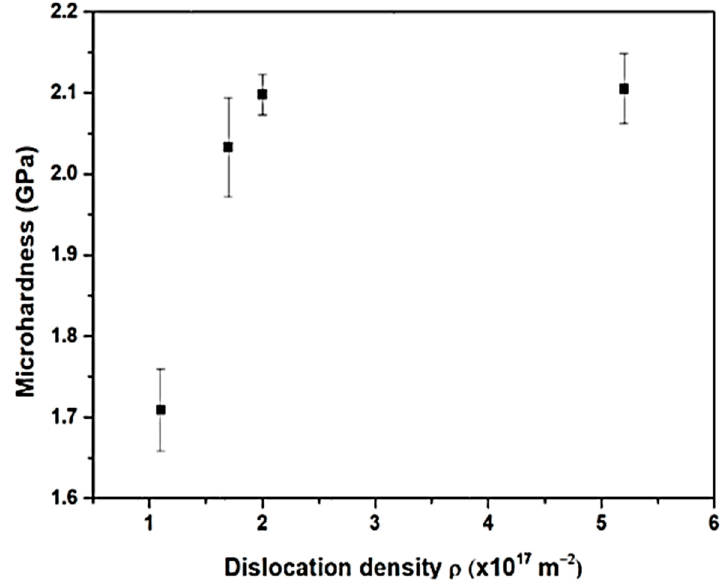
Figure 4. Microhardness as a function of dislocation density of NiTec coatings.